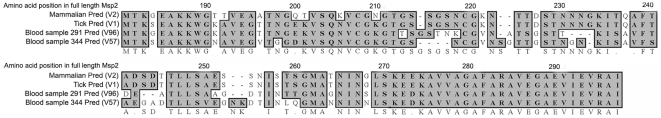
Amino acid sequence alignment of predominant variants found in culture systems and blood samples.Regions that are boxed and shaded in grey indicate conservative amino acid sequences. Conserved amino acid changes are identified by a period. Gaps represent sites of insertions and deletions. The letters in the bottom line represent the amino acid sequence of the consensus sequence. Numbers indicate the position of the amino acids relative to the full length expression locus sequence. V1 represents the predominant variant in tick cell cultures after 21 passages in BME26, 20 passages in DAE100T, 27 passages in ISE6, and 28 passages in IDE12 (following inoculation with cell-free bacteria). V2 corresponds to the predominant variant of tick cells at the following passages: 20 passages in Vero and 19 passages in RF/6A (following inoculation with cell-free bacteria). All samples were taken when infections levels reached >90% at subculture. Average culture times in each cell line were 7 days in ISE6 cells, 9 days in IDE12 cells, 12 days in DAE100T cells, 16 days in BME26 cells, 18 days in RF/6A cells, and 21 days in Vero cells.